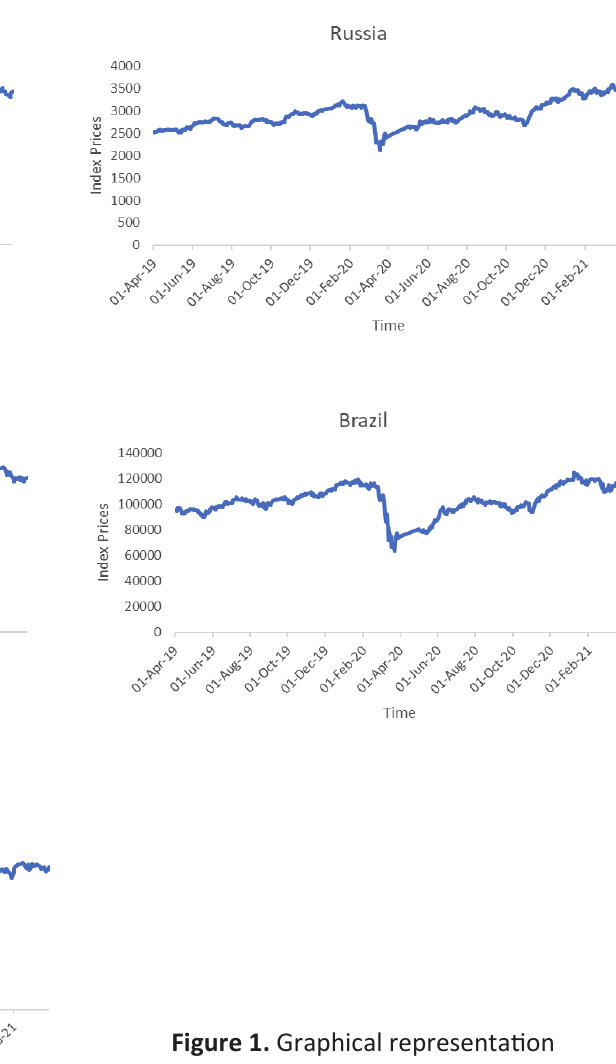
Figure 1. Graphical representation of indices of BRICS